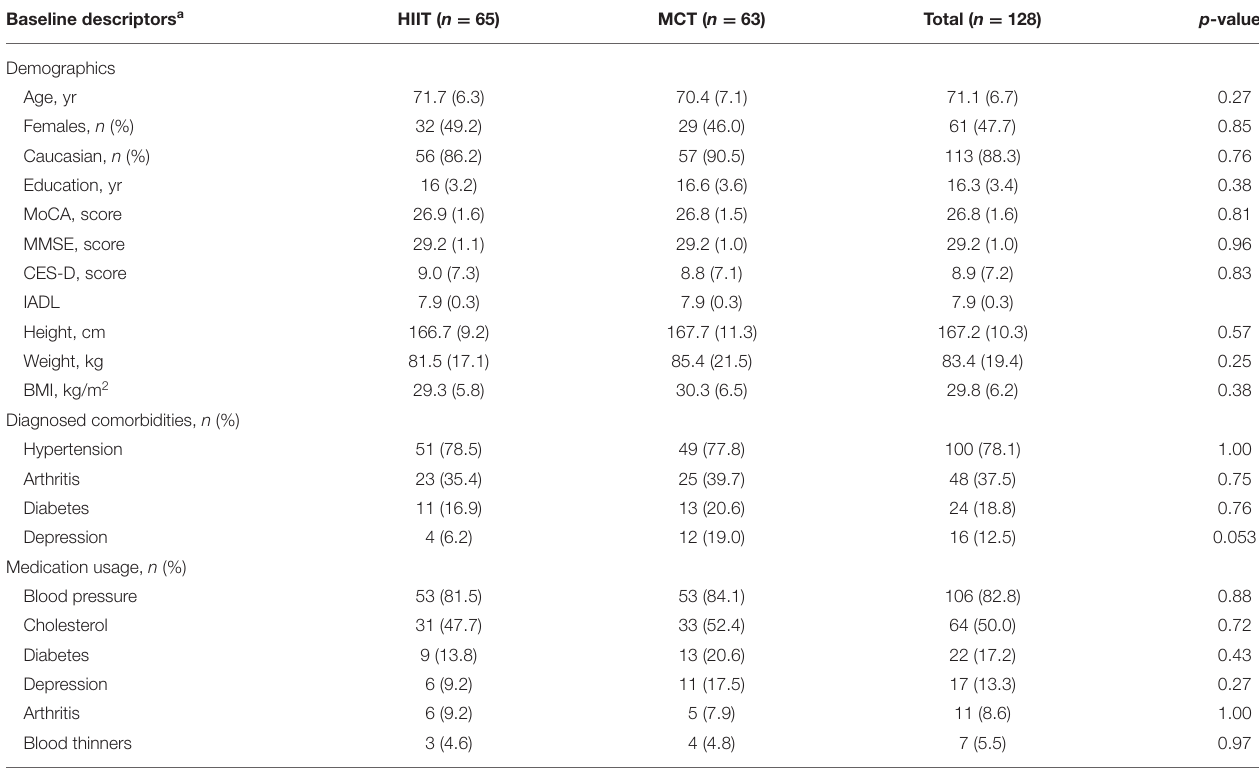
TABLE 1 | Participant demographics and clinical characteristics.